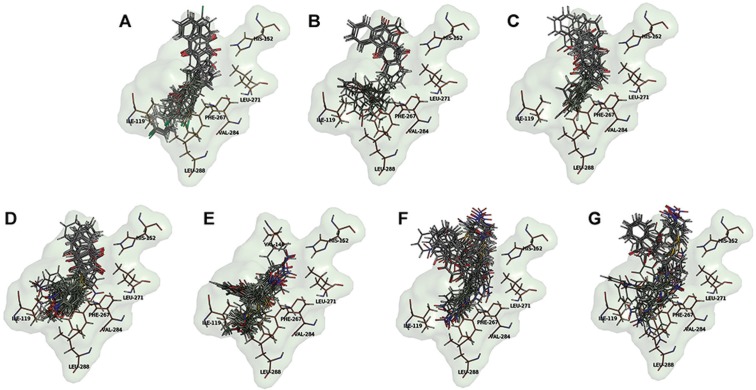
: binding mode analysis for atovaquone analogues in the Qo site in Plasmodium falciparum bc1. For each ligand, the top 20 scoring poses generated in Surflex-Dock are shown. (A) compound 1; (B) compound 3; (C) compound 33R; (D) compound 33S; (E) compound 37R; (F) compound 37S. For reference, selected protein residues in close contact (3.0 Å) with atovaquone are shown in sticks with carbon atoms coloured in orange (His152 from ISP and the others from CYB subunit). Ligand carbon atoms are coloured in gray. Other atoms are CPK coloured.